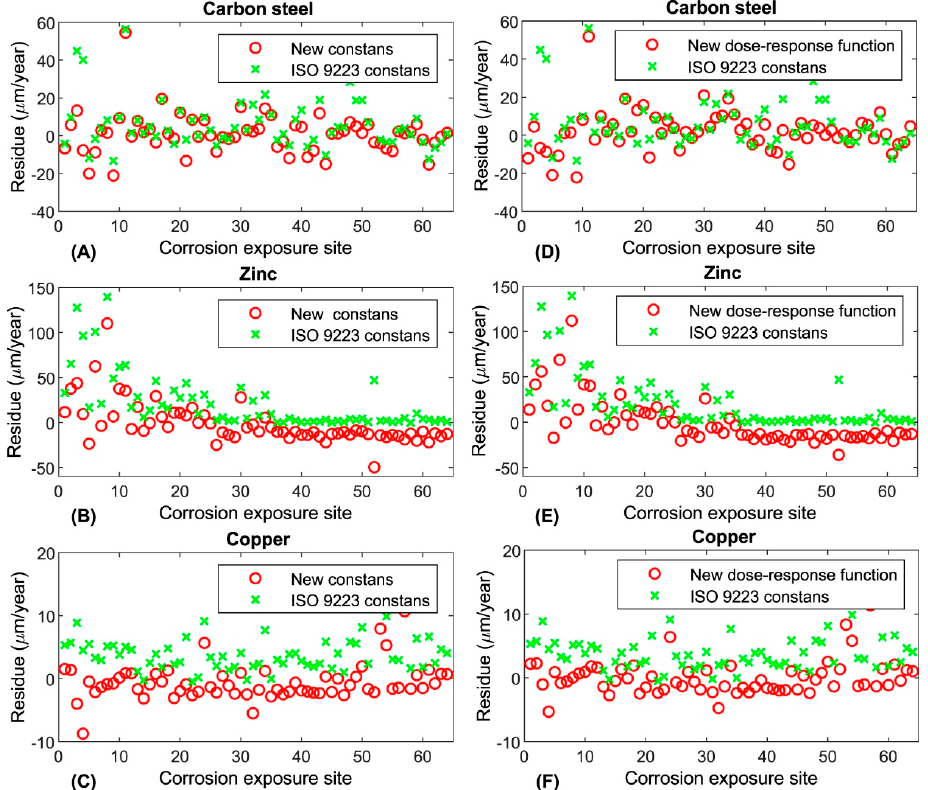
Figure 5. Residue distributions from the application of dose–response functions for normative corrosivity estimation based on calculated first-year corrosion losses. ( A – C ) Application of Equation (1) using either the set of constants given by ISO 9223:2012 [11] or a new set of constants that best fit response function given by Equation (3). Metals: ( A , D ) carbon steel; ( B , E ) zinc; and ( C , F ) copper.